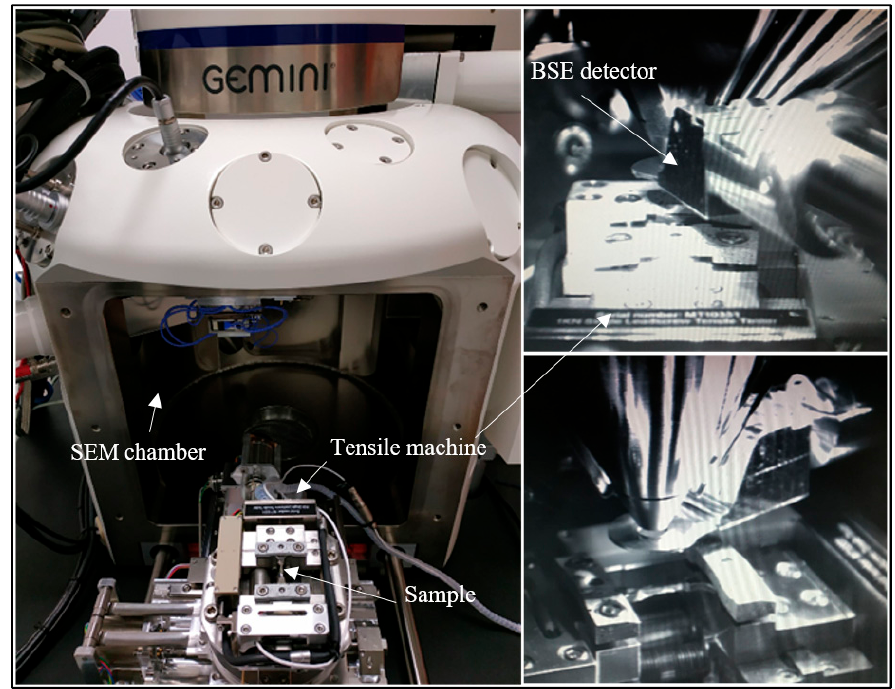
Figure 2. Assembly of the tensile machine/sample inside the Scanning Electron Microscope (SEM); when SEM chamber is opened (left image) and inside the closed SEM chamber with the BackScattered Electrons (BSE) detector inserted (right images).